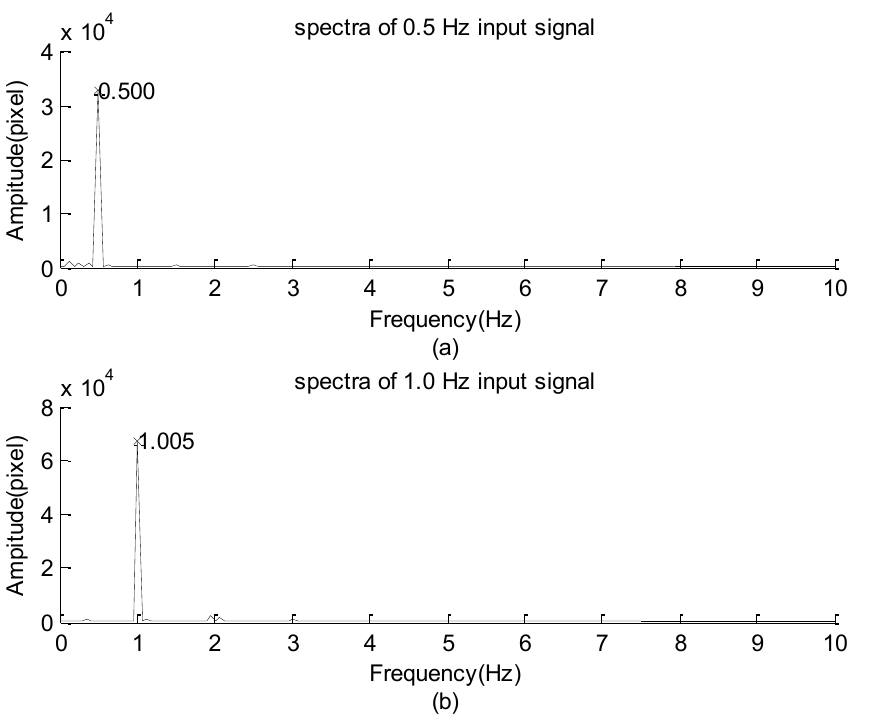
Figure 8. Spectra distribution of LED signal collected by the webcam: ( a ) 0.5 Hz input signal. ( b ) 1.0 Hz input